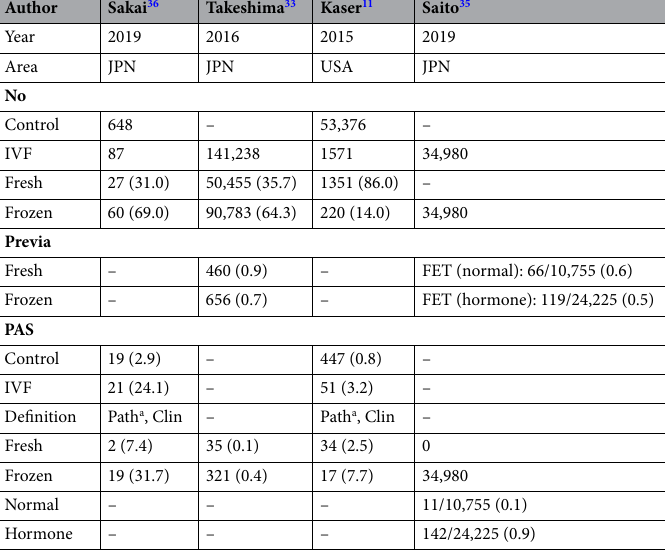
Table 4. Comparator analysis of PAS between frozen ET versus fresh ET groups. Number (percentage per column) is shown. a included cases without cesarean hysterectomy. –, not applicable; JPN , Japan, USA ,